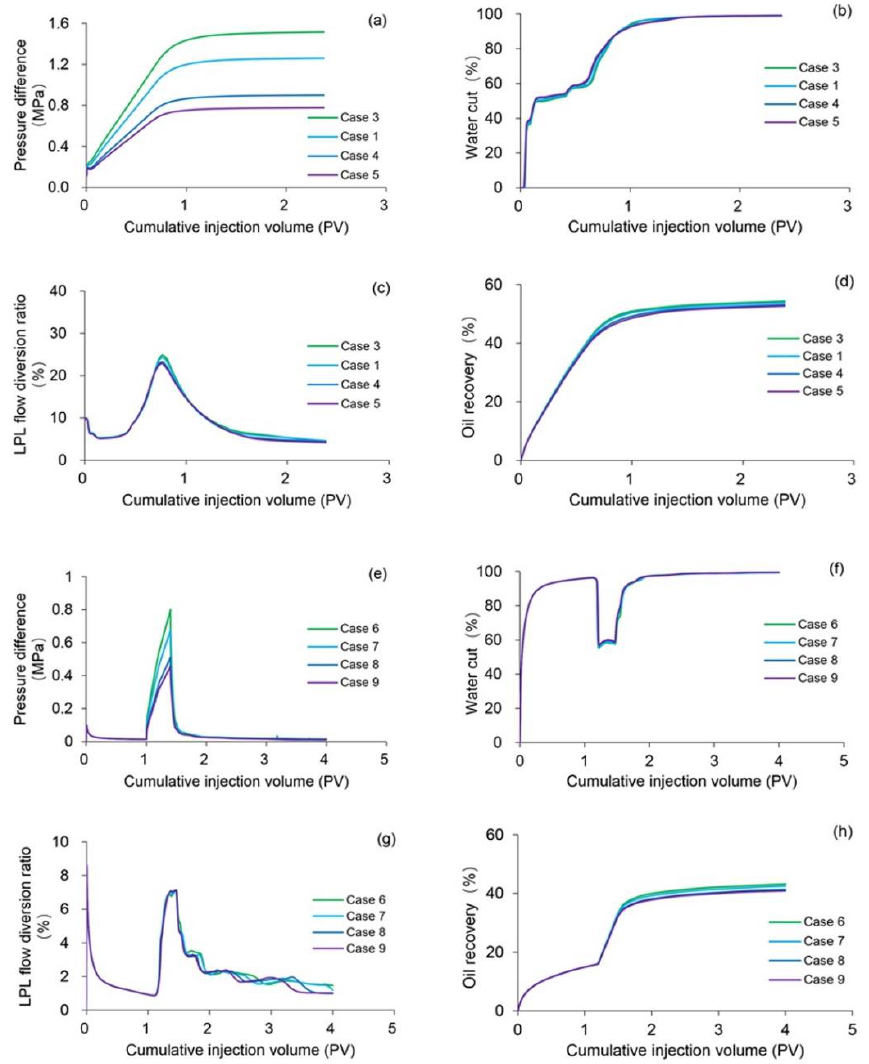
Figure 13. Comparison results of ( a ) pressure difference, ( b ) water cut, ( c ) LPL flow diversion ratio and ( d ) oil recovery of Cases 1 and 3 – 5, and those of ( e ) pressure difference, ( f ) water cut, ( g ) LPL flow diversion ratio and ( h ) oil recovery of Cases 6 – 9.